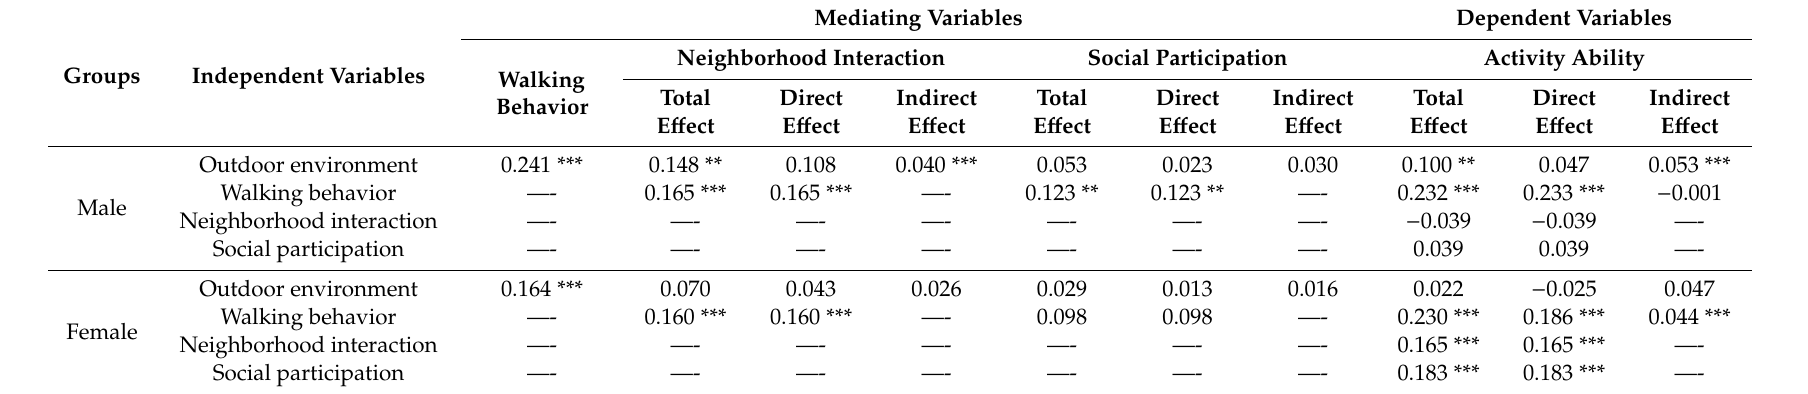
Table 3. Total e ff ect, direct e ff ect, and indirect e ff ect in the model.